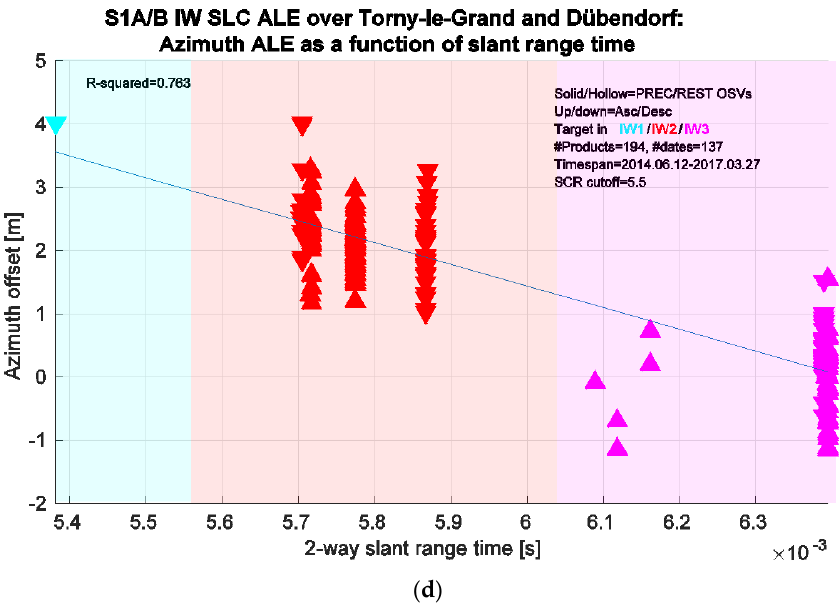
Figure 4. S-1 IW mode SLC geolocation accuracy based on products acquired over Swiss test sites from 2014 to 2017: ( a ) S-1A; ( b ) S-1B; ( c ) S-1A/B combined; ( d ) azimuth error vs. slant range time for IW mode SLC products, with least-squares fit. Coloured regions indicate approximate subswath ranges.